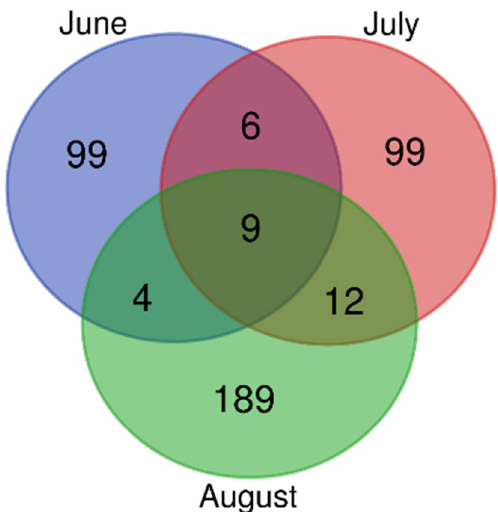
Figure 3. Venn diagram of differentially accumulated metabolites for each sampling time (June, July, August) of buffaloes fed TMR and TMR + 30% green forage.